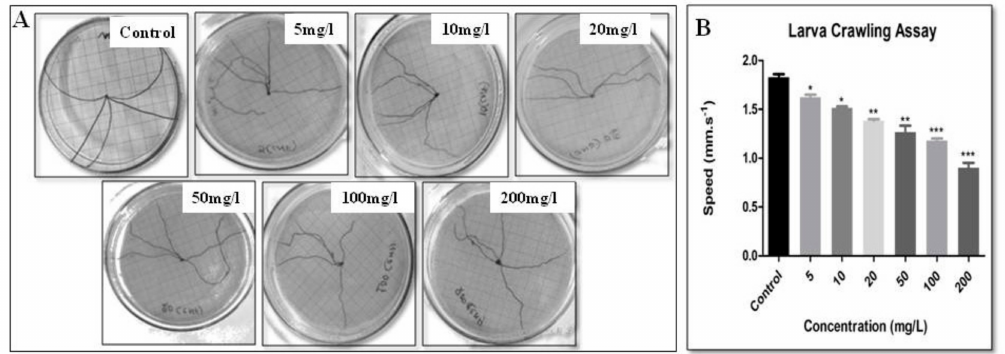
Figure 2. Larval crawling assay to check the speed of the larvae and trailing path. ( A ) Trailing path of the larvae. ( B ) Distance traveled by larva in millimeters per second (* for p -value < 0.05, ** for p -value < 0.001, *** for p -value <